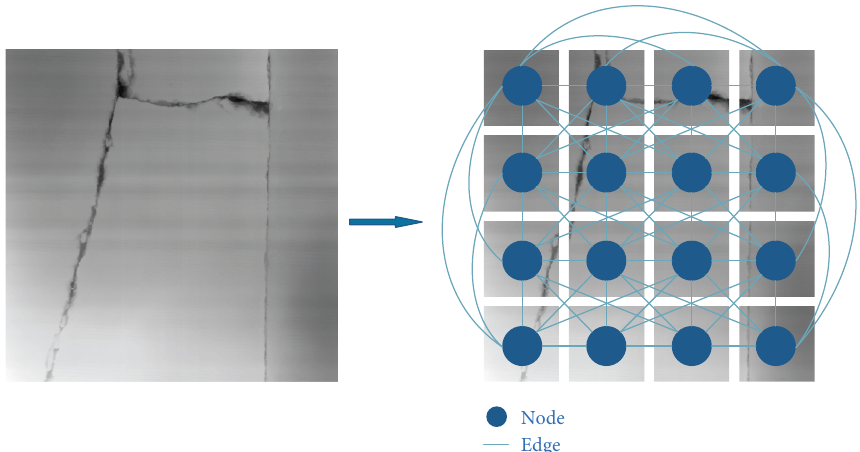
Figure 1: Schematic of transforming an image into a graph.